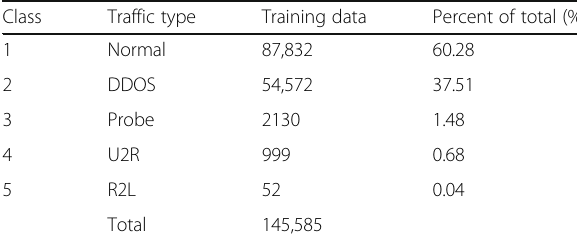
Table 5 Distribution for the 10% KDD Cup 99